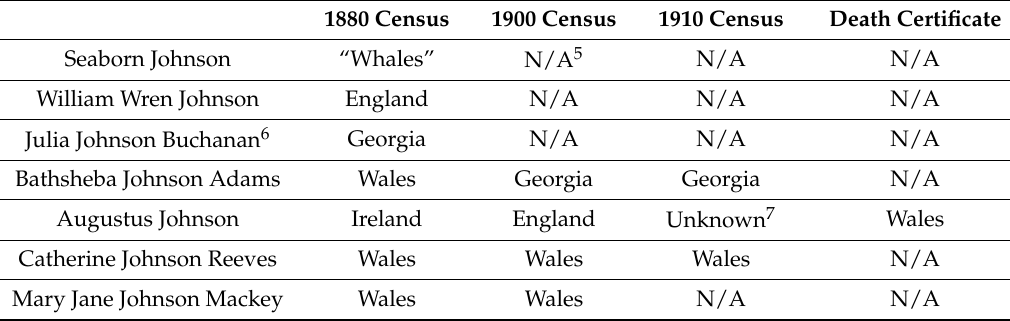
Table 1. Data about their father’s place of birth given in census